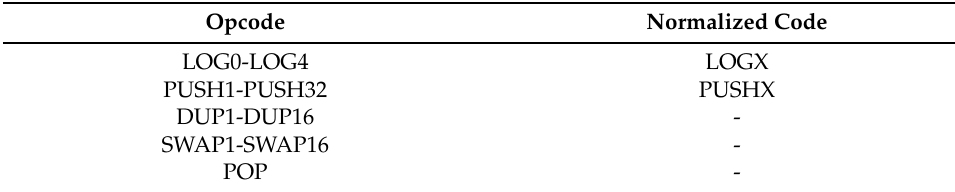
Table 1. Opcode normalization.